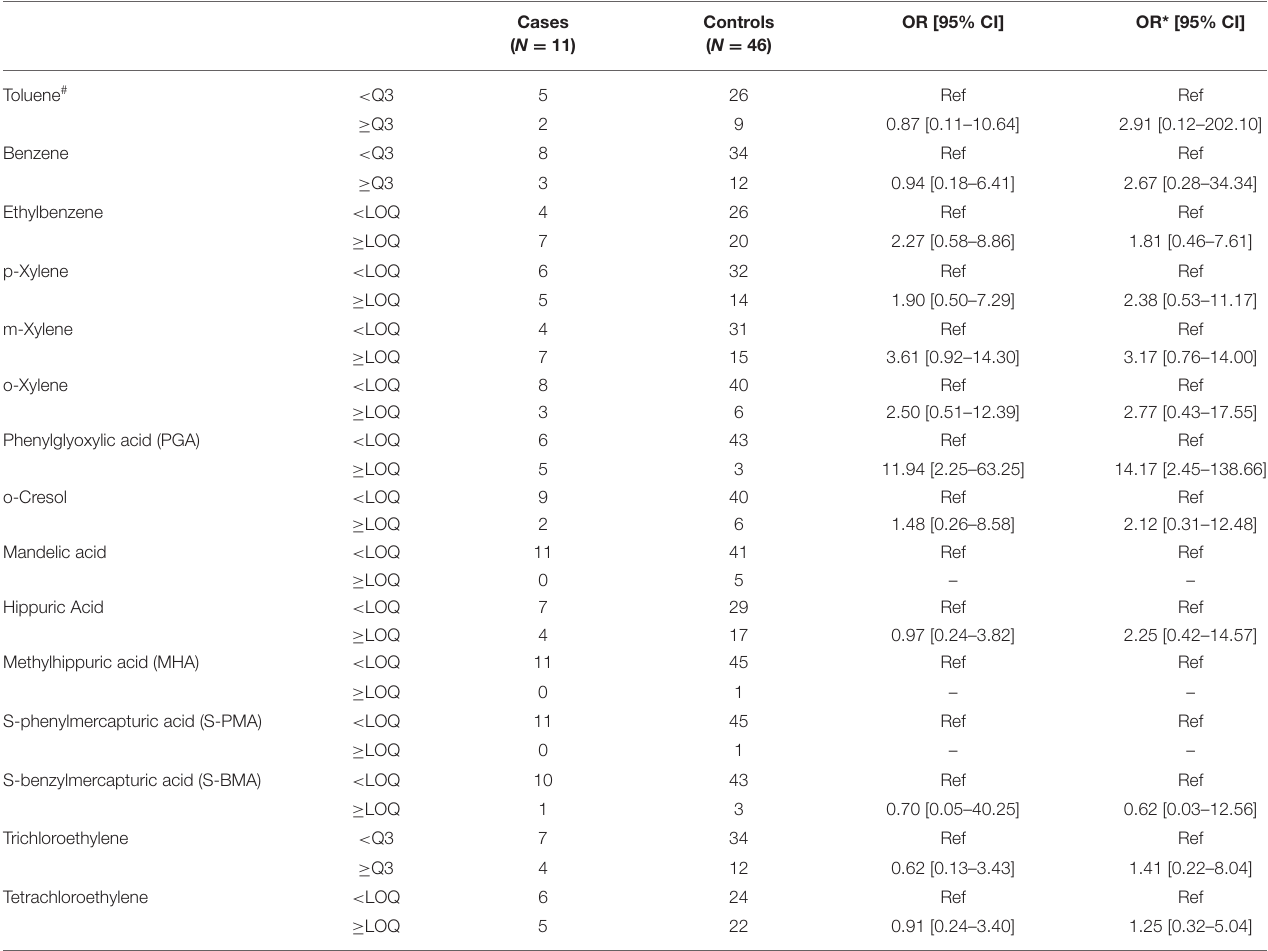
TABLE 3 | Association between the levels of BTEX and chlorinated solvents and their metabolites in the meconium and the occurrence of hypospadias ( n = 11 cases and 46 controls).